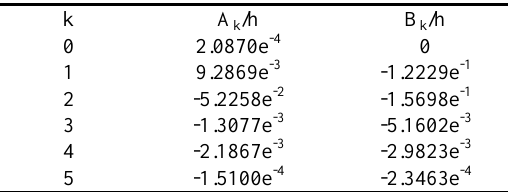
Table 1. The value of the parameter